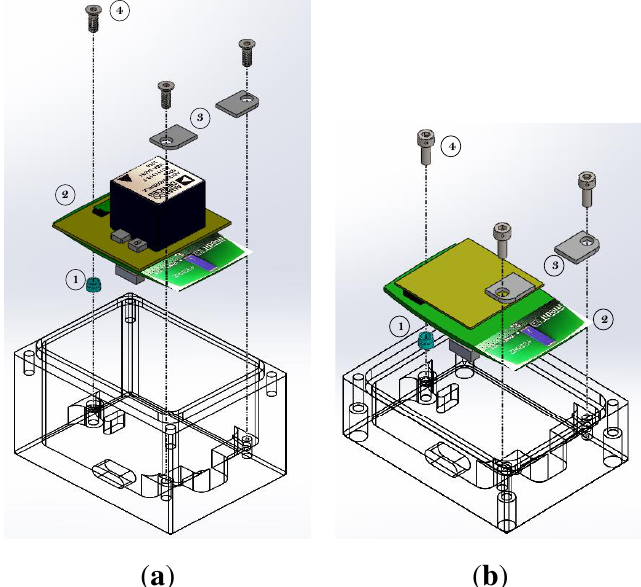
Figure 6. Design of the calibration case (1, Insert, aluminum; 2, 9DOF MARG sensor system; 3, Insert, plastic; 4, M3 screw, steel). ( a ) IPANEMA ADIS16400 arrangement; ( b ) IPANEMA EXO